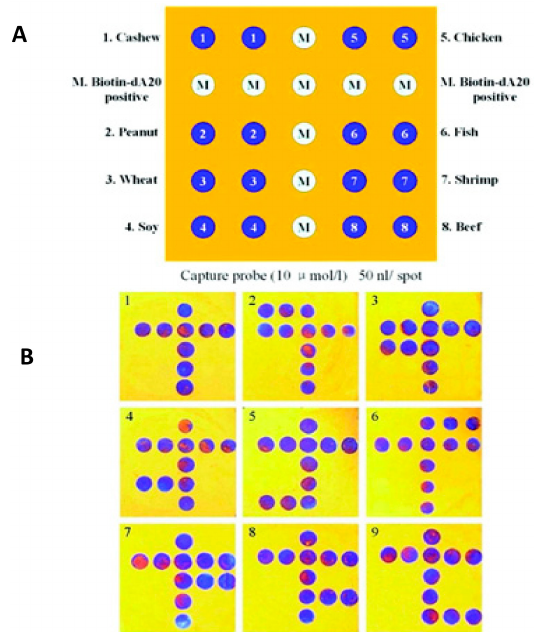
Figure 8. Allergen-detection chip. ( A ) Food probes were spotted in addition to positive control and marker (M); ( B ) detection of corresponding allergens: 1, H 2 O; 2, cashews; 3, peanuts; 4, wheat; 5, soybeans; 6, chicken; 7, fish; 8, shrimp; 9, beef (reprinted with permission from Reference [89]. Copyright 2011, American Chemical Society).